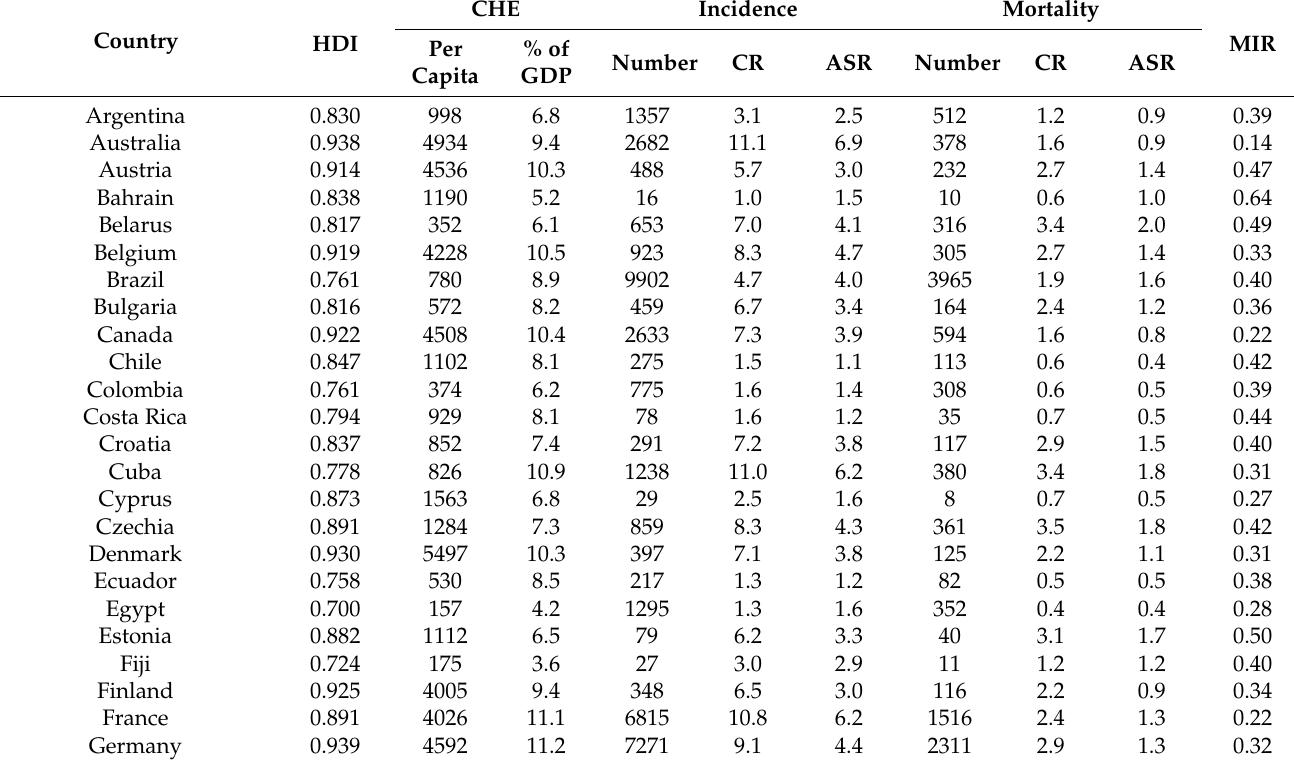
Table 2. Summary of HDI, CHE, cancer incidence, cancer mortality, and MIR in lip and oral cancer (N = 61).